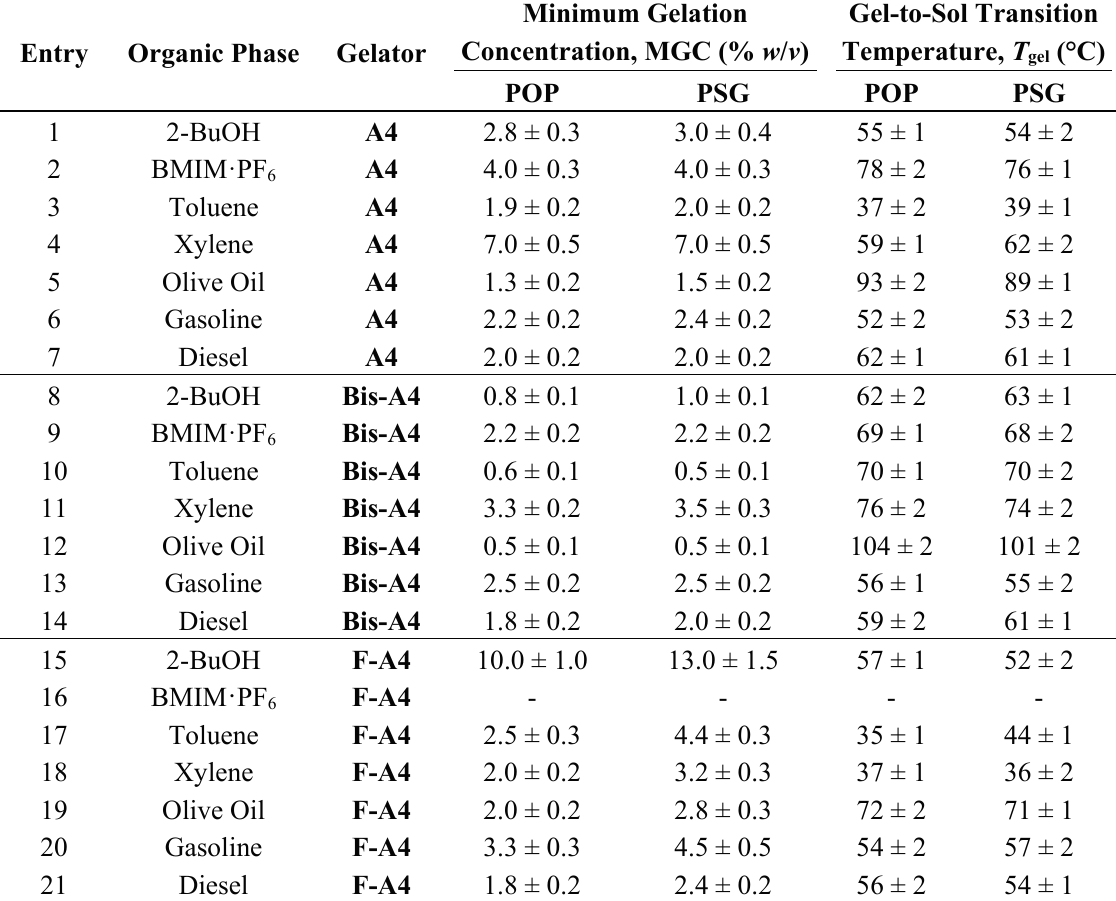
Table 1. Comparison of the gelation properties of pure organic phases (POP) and phase-selective gelation (PSG) for selected organic